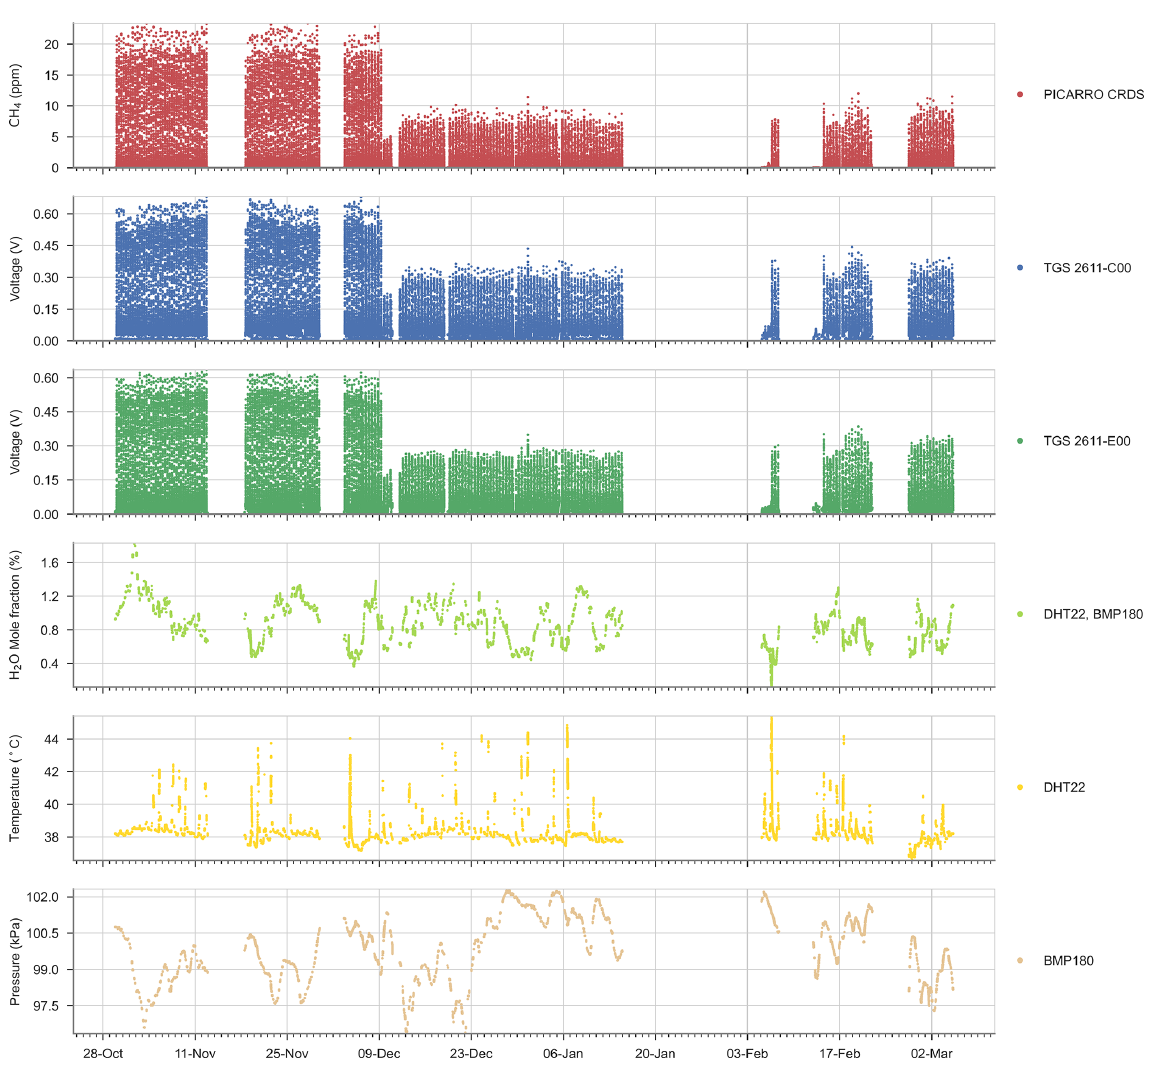
Figure A4. Time series of the reference CH 4 signal, Figaro ® TGS sensor and environmental variables for the entire experiment.